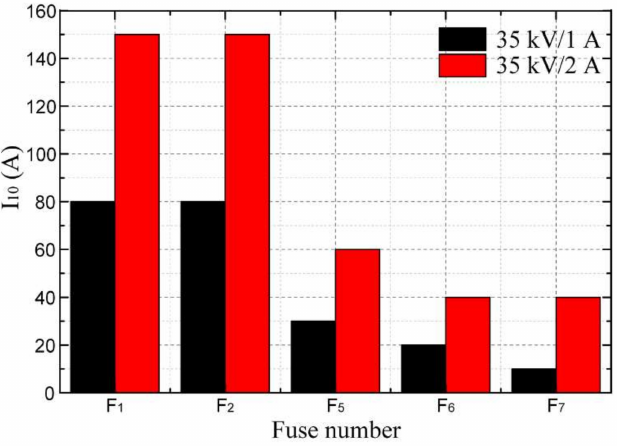
Figure 9. Highest impulse current amplitude borne by 35 kV